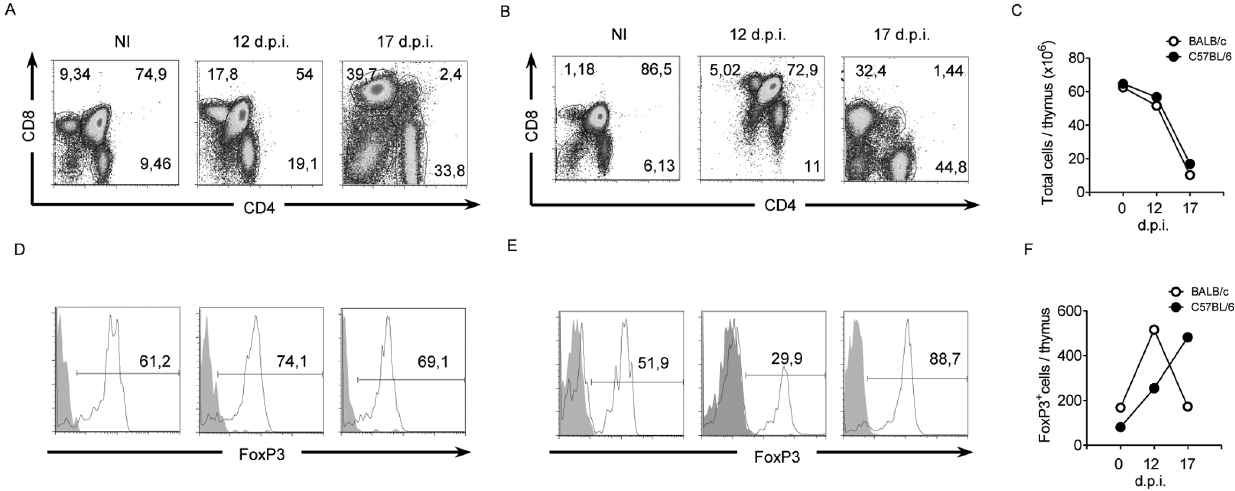
Figure 2. Infected C57BL/6 mice show higher numbers of nT reg cells than infected BALB/c mice. Non-infected (NI) BALB/c and C57BL/6 mice and mice infected with high inoculum were sacrificed at 0 (NI), 12 and 17 d.p.i. Thymocytes were counted and stained with antibodies against cell surface molecules and intracellular markers and analyzed with a flow cytometer. Data from BALB/c and C57BL/6 mice are represented by open circles and filled circles, respectively. ( A ) Anti-CD4 and anti-CD8 antibody staining of thymocytes from non-infected (NI) BALB/c mice at 12 and 17 d.p.i. ( B ) Anti-CD4 and anti-CD8 antibody staining of thymocytes from non-infected (NI) C57BL/6 mice at 12 and 17 d.p.i. ( C ) Total number of thymocytes per thymus in BALB/c (open circles) and C57BL/6 mice (filled circles). ( D ) Staining of the gated CD4 + CD25 + population with anti-FoxP3 antibody in BALB/c mice. (E) Same as ‘‘D’’ for C57BL/6 mice. (F) Total number of FoxP3 + cells per thymus. Data represent the results of at least two independent experiments performed with samples pooled from 3 mice per experimental